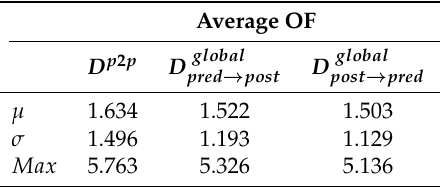
Table 15. Numerical evaluation: Point-wise and global distance (in mm) between predicted and post-surgery PCLs using heuristic model. The training set is sampled with rate of